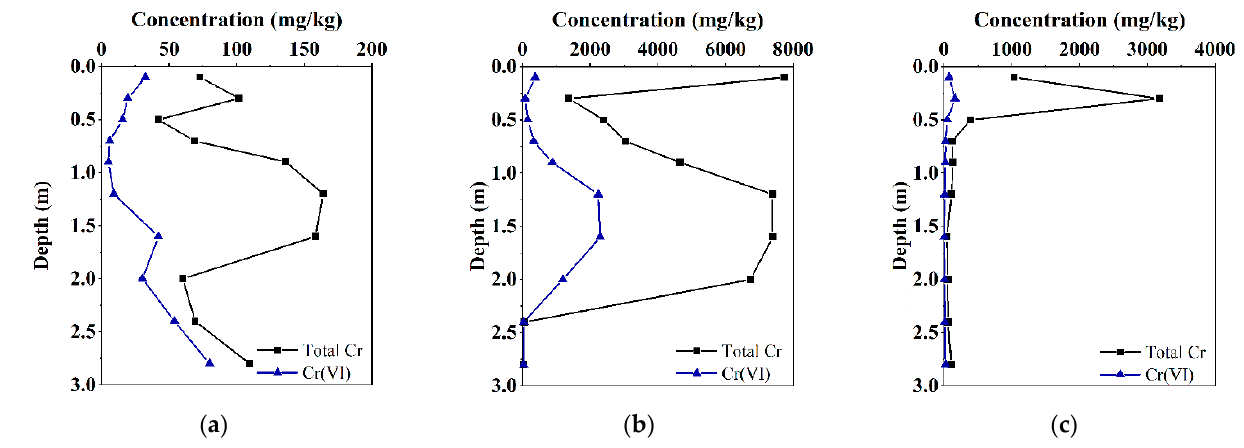
Figure 3. The vertical distribution of CrT and Cr(VI) in the soils at contaminated sampling point S2 ( a ), S3 ( b ) and S5 ( c ). S2 ( a ), S3 ( b ) and S5 ( c